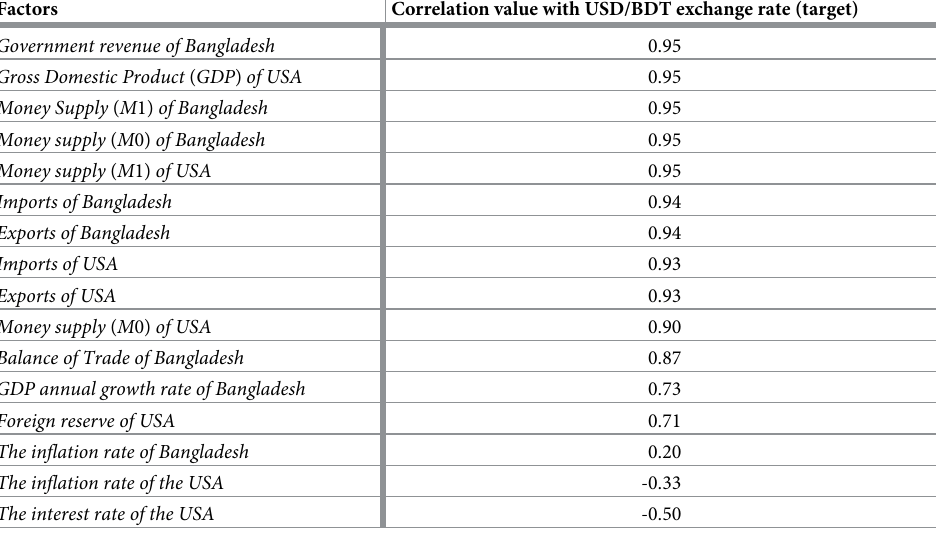
Table 2. Correlation (Spearman’s) between features(factors) and